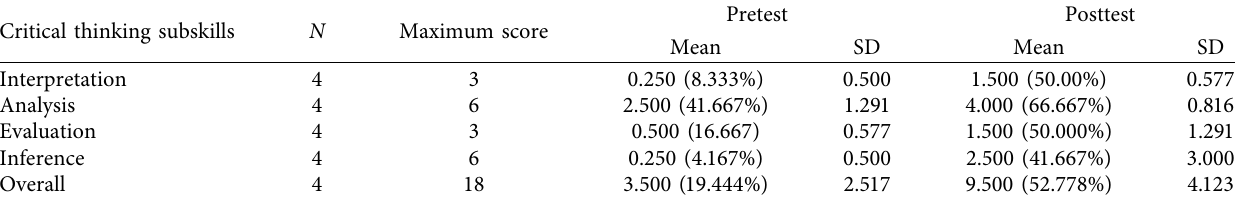
Table 8: High-achieving: means and standard deviations for pre- and post-test